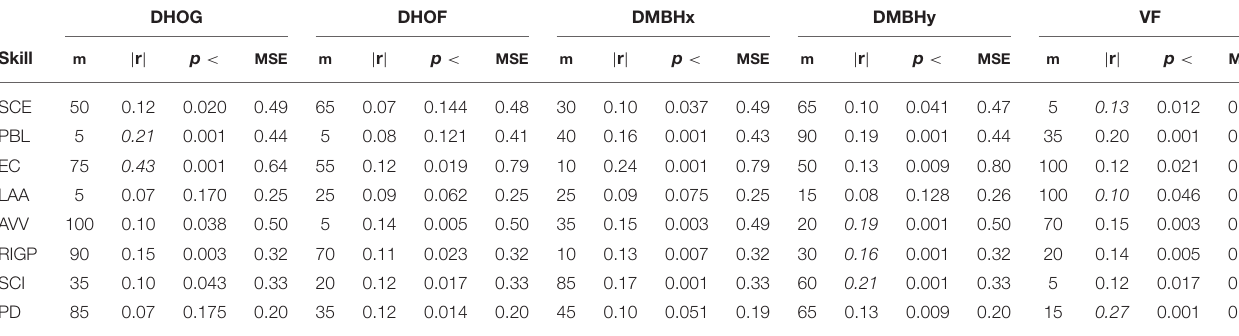
TABLE 5 | Best SVM regression model results for each presentation delivery skill for each visual data representation method.